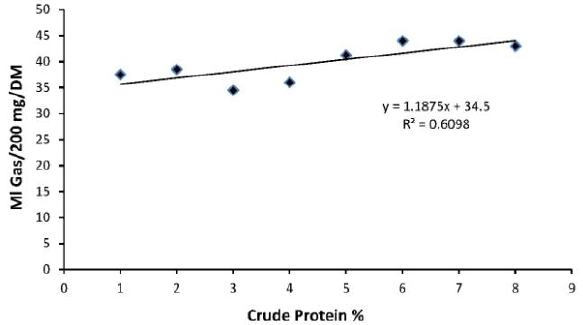
Figure 1. Relationship between in vitro gas production and crude protein percentage in forage